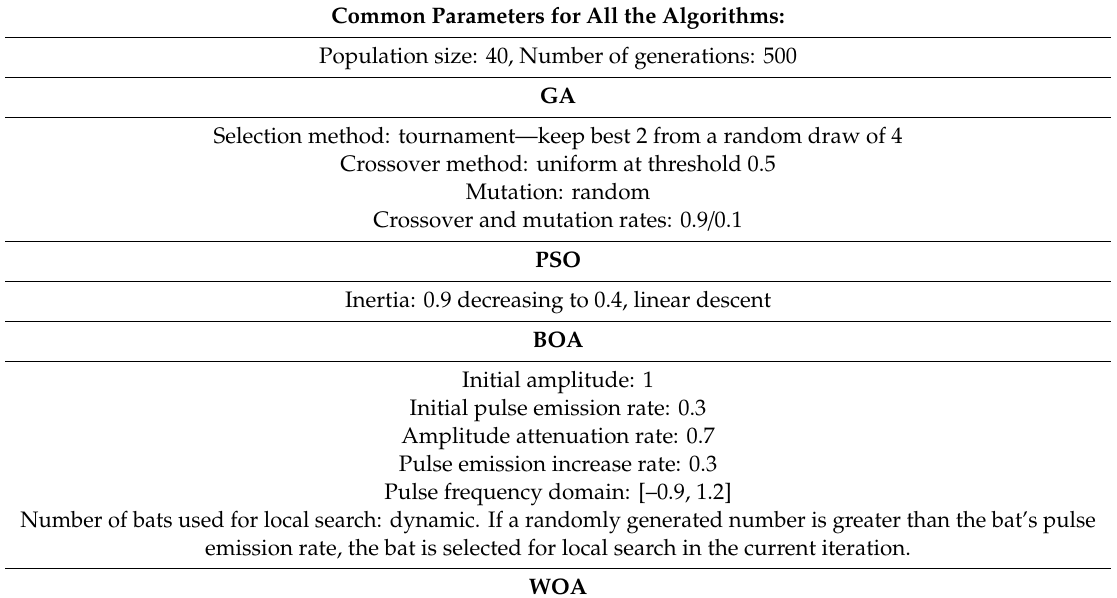
Table 3. The initial parameters used for the metaheuristic algorithms. Common Parameters for All the Algorithms: